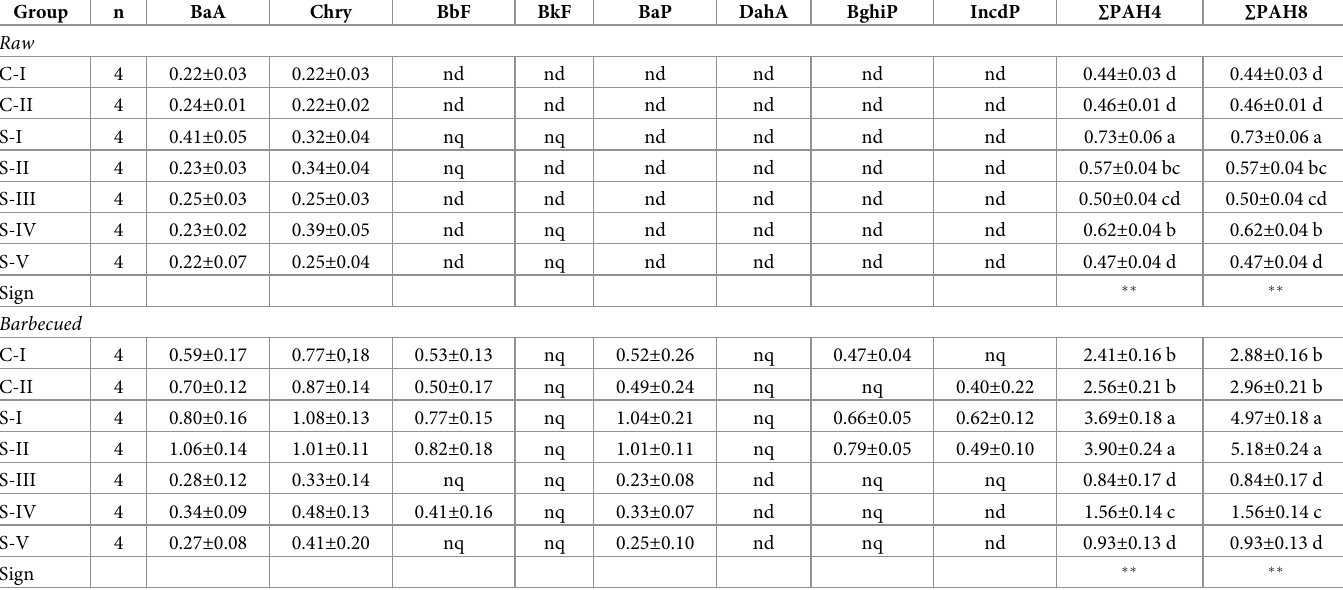
Table 1. Polycyclic aromatic hydrocarbon (PAH) contents of raw and barbecued non-smoke flavored and smoke flavored salmon fillets with different smoking wood chips (ng/g).